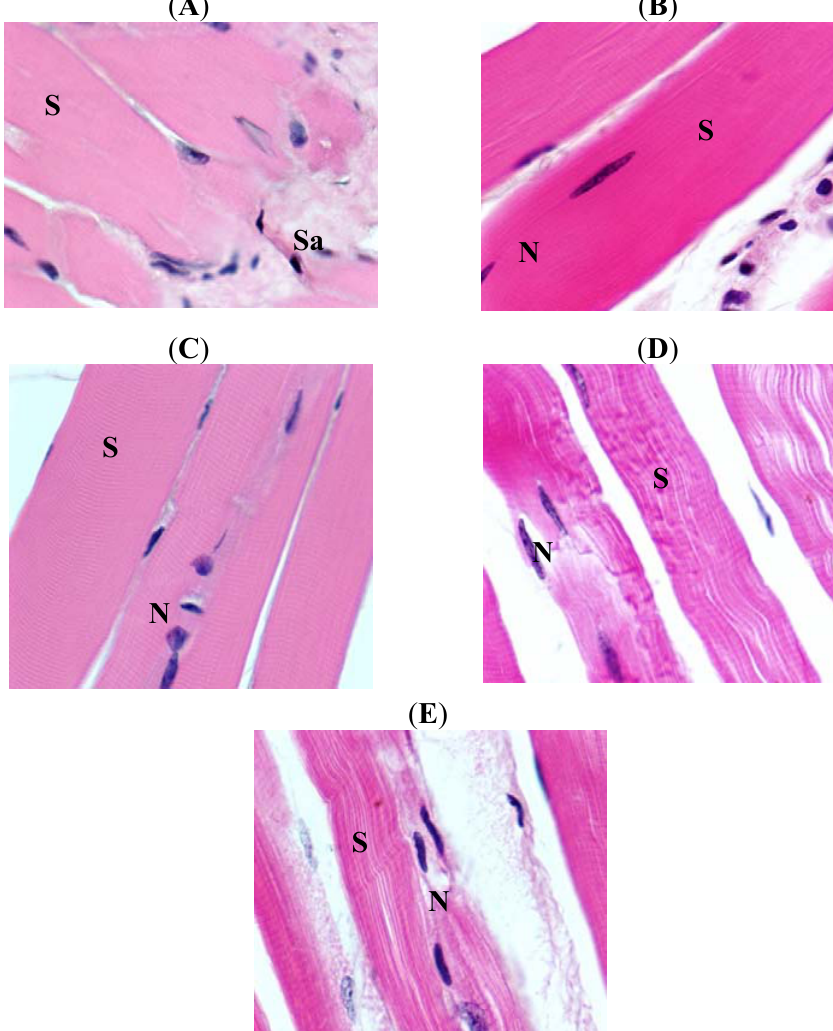
Figure 1. Histology of muscle samples. ( A ) Interstitial fibrosis changes in skeletal muscle (×1,000) of Group I. ( B ) Skeletal muscles with normal architecture (×1,000) of Group II. ( C ) Skeletal muscles with normal architecture (×1,000) of Group III. ( D ) Skeletal muscle with wavy appearance fibers (×1,000) of Group IV. ( E ) Normal architecture of muscle fibers (×1,000) of Control